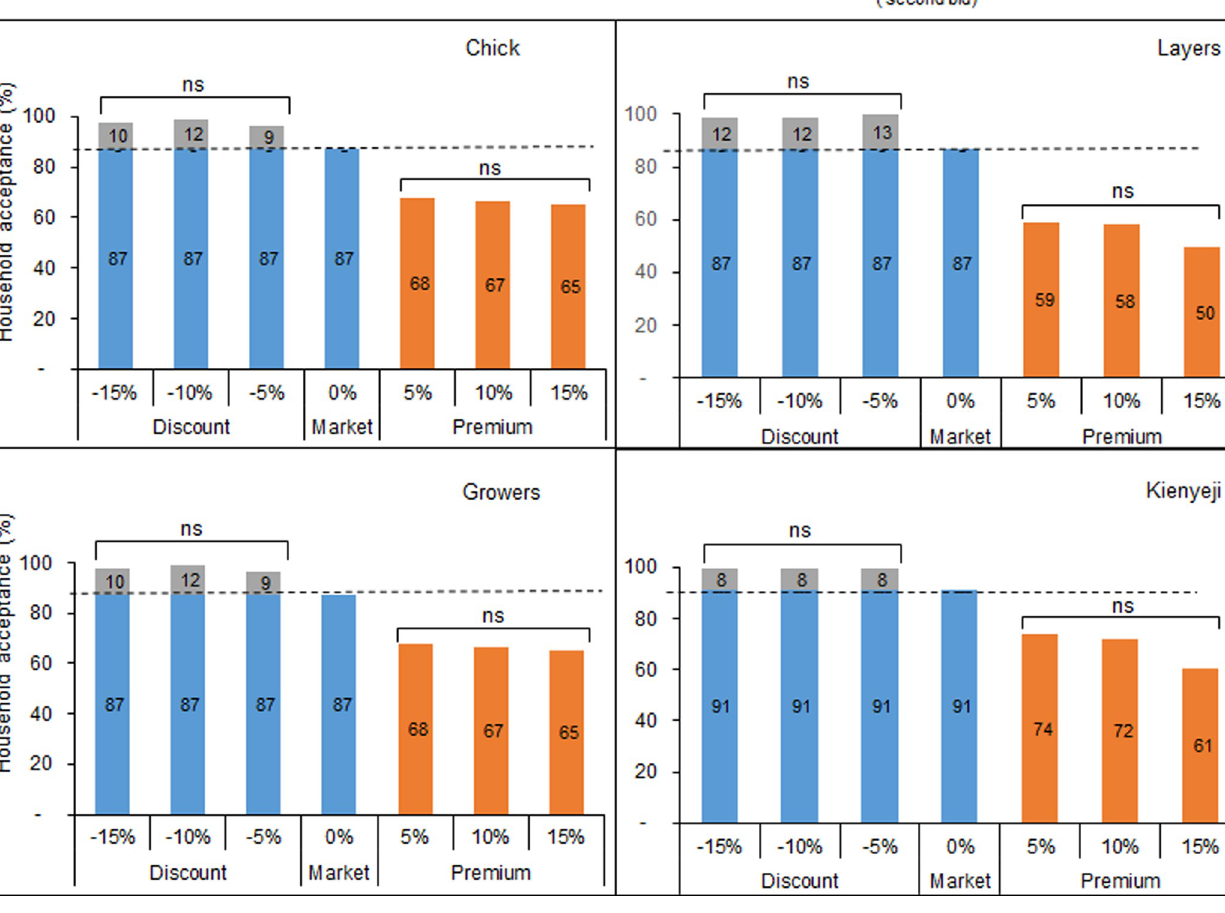
Fig 5. Effect of bid offers on willingness to pay (WTP) level among poultry farmers. The broken line indicates the market price. Bars with “ns” are not significantly different, P < 0.05, Chi-squared test. Chick mash = a ground form of feed fed to chicks aged 0–8 weeks. Growers = feed for birds aged 8–18 weeks. Layers = feed formulated for laying birds aged 19–76 weeks. Kienyeji = a ground form of feed for indigenous type of chicken commonly known as “Kienyeji”.